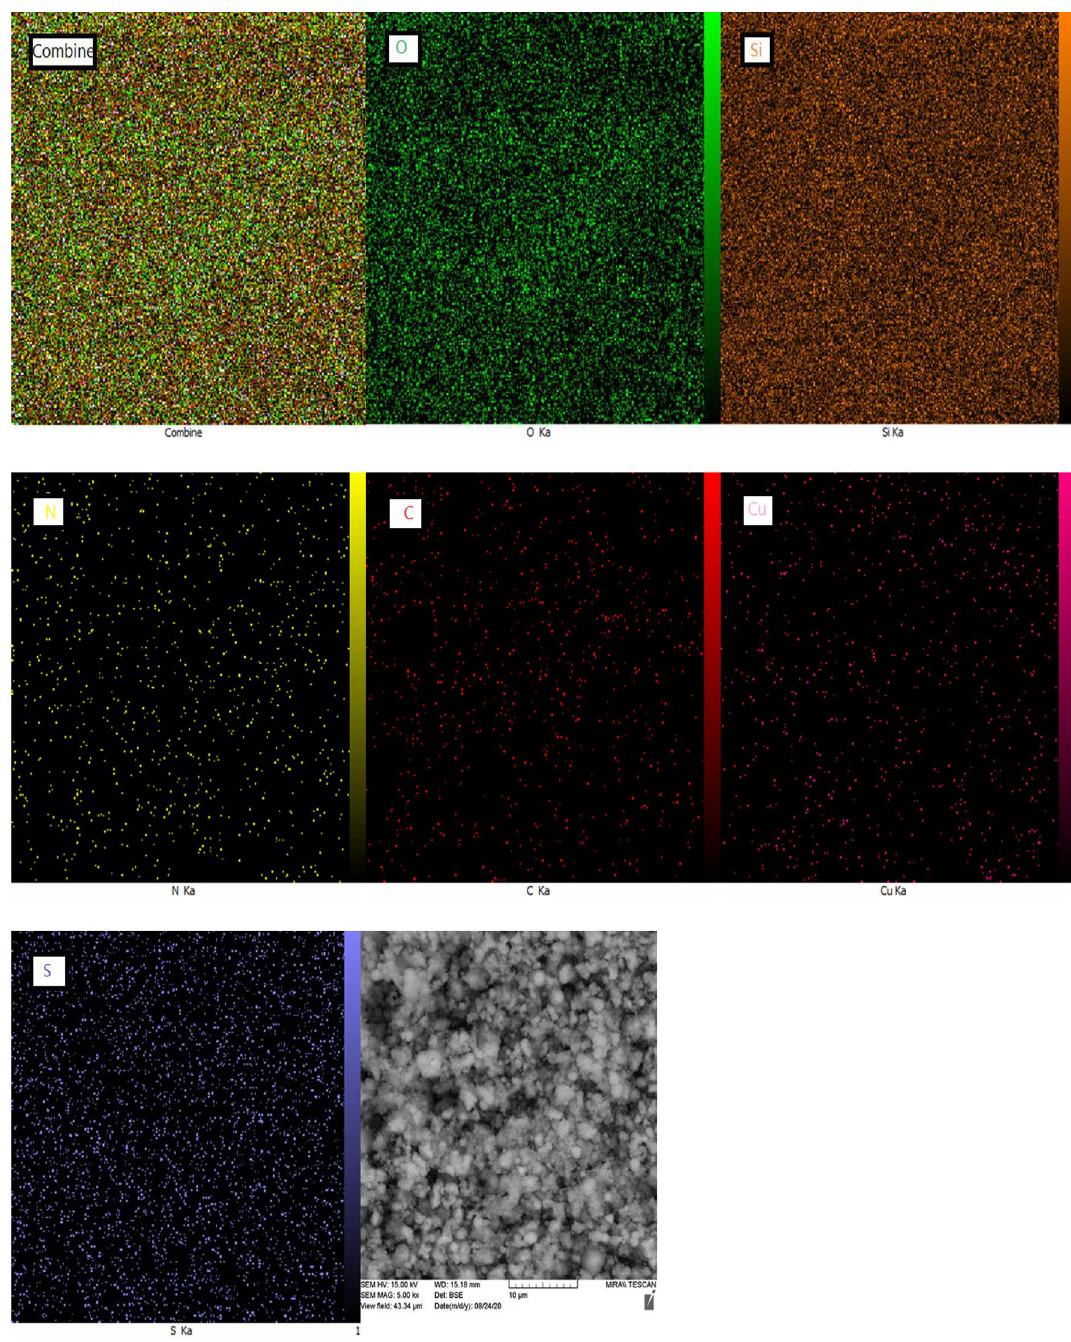
Figure 17. The elements mapping analysis of HMS/Pr-PTSC-Cu.